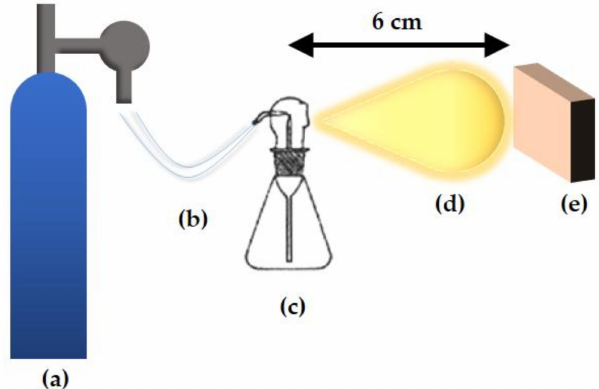
Figure 3. The experimental set up for spray coating substrates (Silicon chips or Lecce stone specimens) with TiO 2 NRs. A controlled amount of nitrogen was fluxed from the gas cylinder ( a ) to the nebulizer ( c ) through the rubber tube ( b ). The nebulizer contained the chloroform/n-heptane dispersion of TiO 2 NRs, which was finally sprayed on the substrate ( e ) located at the distance of 6 cm from the nebulizer. Table 1. The experimental conditions used for the preliminary investigation of the morphology of TiO 2 NRs films on silicon substrates achieved by spray coating. The suffixes -ch and -he indicate whether the sample was prepared from a chloroform or an n-heptane dispersion of TiO 2 NRs, respectively. Sample Name Application Time